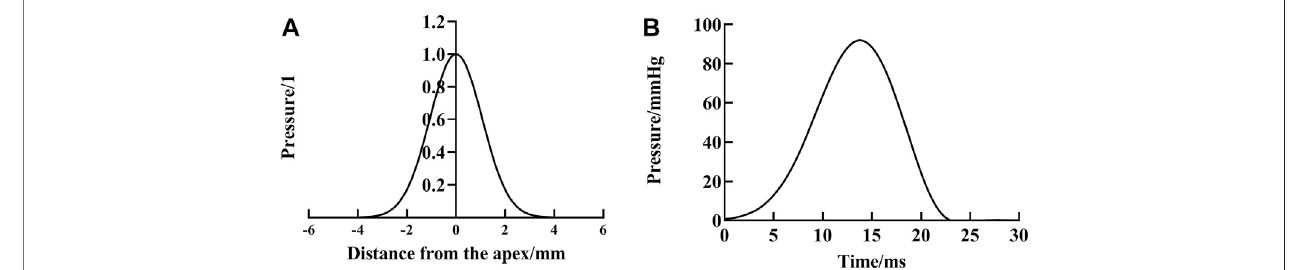
FIGURE 1 | Air-puff applied to cornea by Corvis ST, variation of space (A) and time (B) .